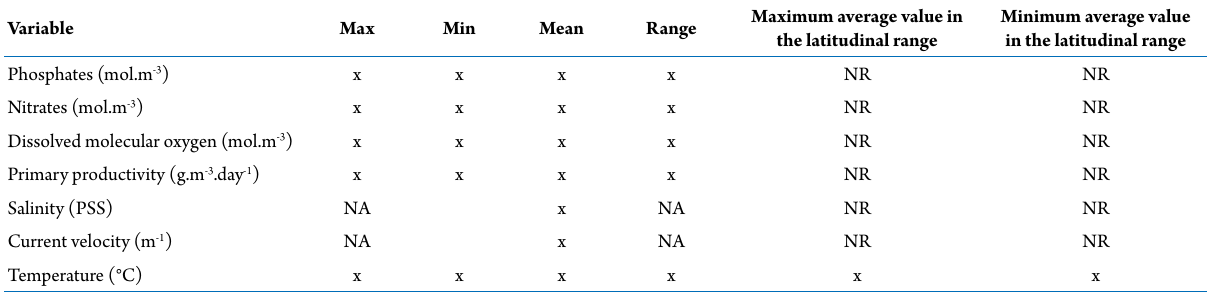
Maximum average value in Minimum average value the latitudinal range in the latitudinal range